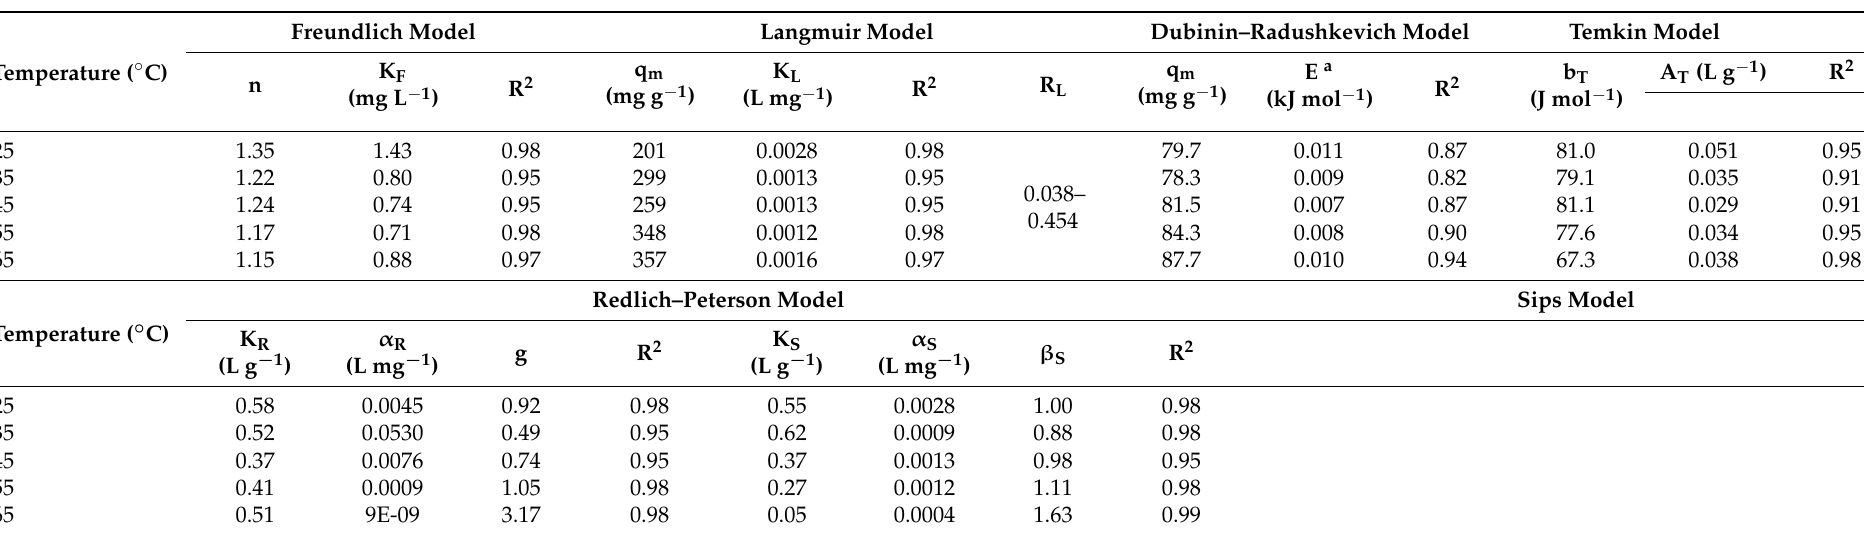
Table 3. Isotherm parameters using nonlinear simulation for the adsorption of ectoine onto Dowex ® HCR-S using the Freundlich, Langmuir, Dubinin–Radushkevich, Temkin, Redlich–Peterson, and Sips